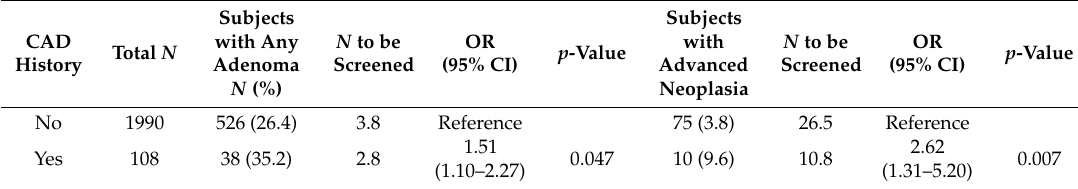
Table 2. Colorectal lesion and advanced neoplasia by CAD history.